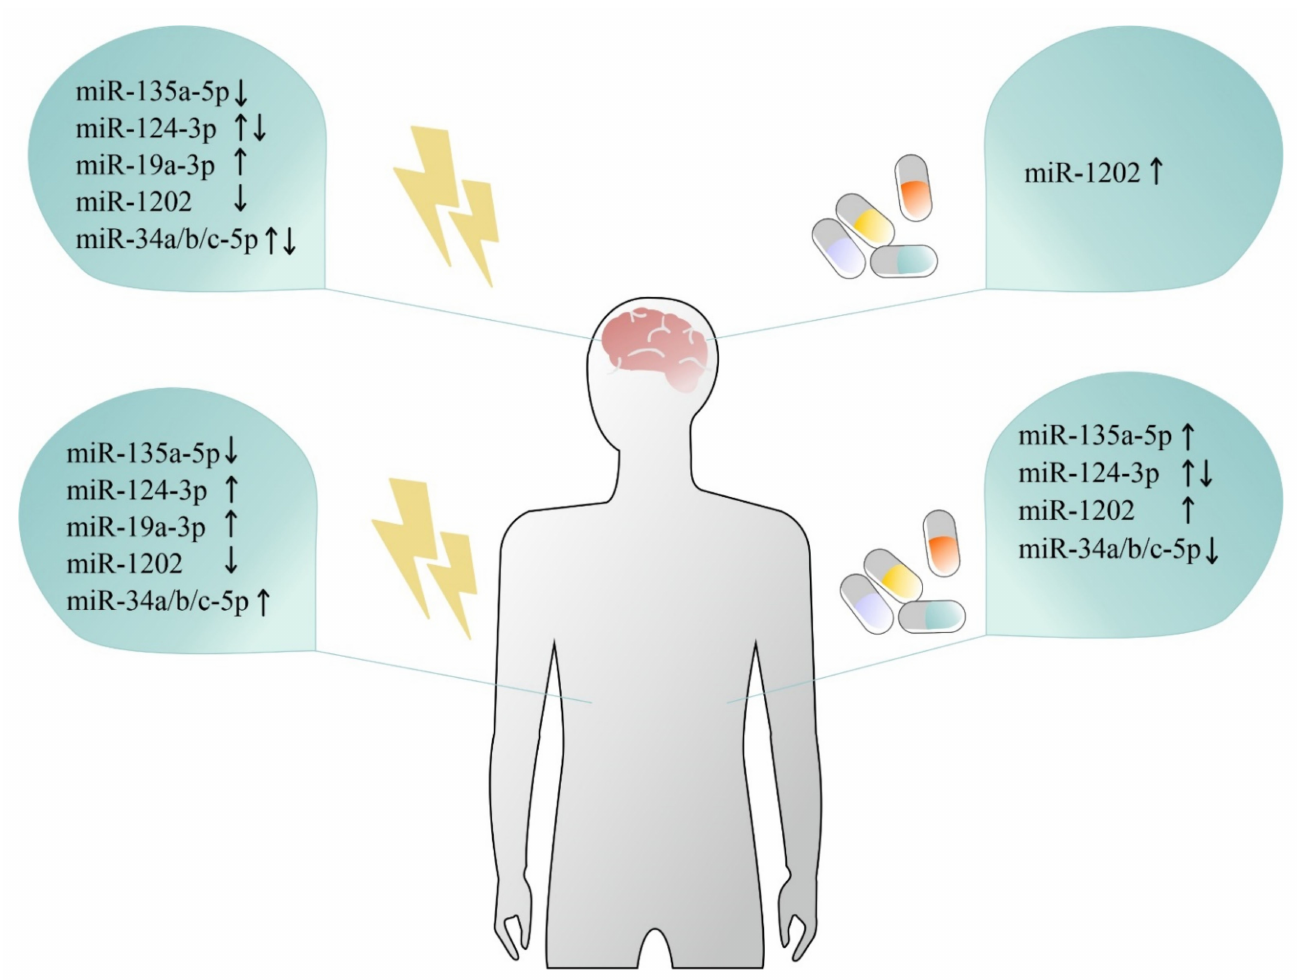
Figure 1. Graphical summary of miRNA changes observed in depression and antidepressant response at the level of brain as well as peripheral tissues. Left panel represents directions of changes in the expression of miRNAs found in brain and periphery in depressed vs. healthy controls. Right panel represents directions of changes in the expression of miRNAs found in brain and periphery in depressed patients after different antidepressant